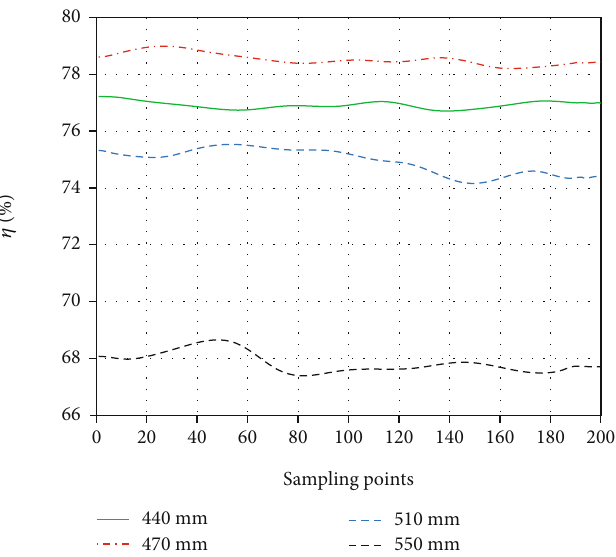
Figure 13: The variation of e ffi ciencies with various lengths of Bowden